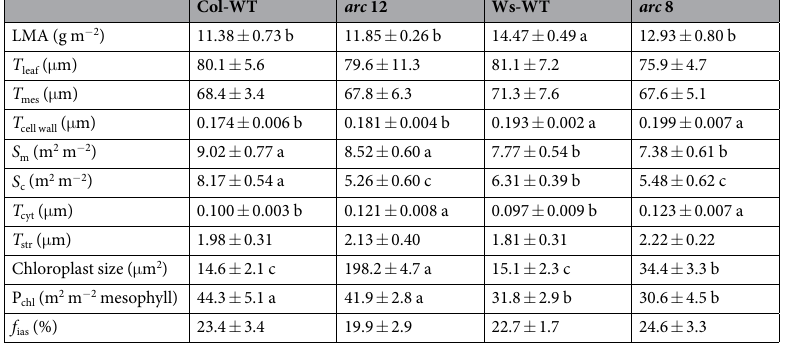
Table 4. Leaf anatomical characteristics. The values shown are the mean ± SD of three replicates. The means were compared with a least significant difference (LSD) test; values followed by the same letter are not significantly different ( P < 0.05). LMA, leaf mass per leaf area; T leaf , leaf thickness; T mes , mesophyll thickness; T cell wall , cell wall thickness; S m , mesophyll cell surface area face to intercellular air space per leaf area; S c , chloroplast surface area face to intercellular air space per leaf area; T cyt , cytoplasm thickness; T str , chloroplast stroma thickness; P chl ,